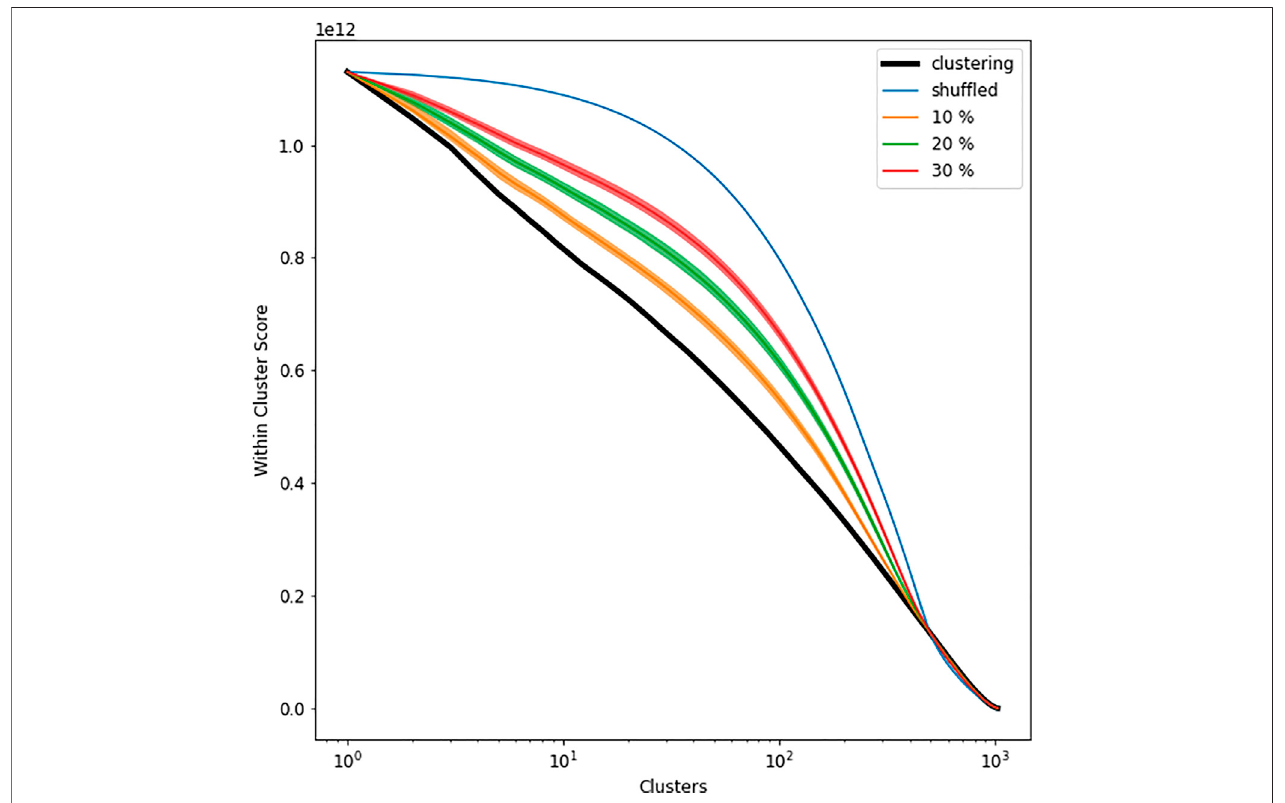
FIGURE 2 | The cluster total of the in-cluster sum of square distances versus the number of clusters (log scale): the black curve shows the calculation for Ward clusteringoftheactualdata;bluecurvesshowsan envelope oftheequivalentcalculatedcurveswhereallofthepairwiseexperimental distancesarerandomlypermuted; the yellow, green, and red curves show envelopes based on 1,000 samples for each line where a random 10% 20 and 30% of the pairwise experimental distances are redrawn from the distribution of all such values (with replacement): in each case a dark median is drawn together with the 1st to 99th percentiles.